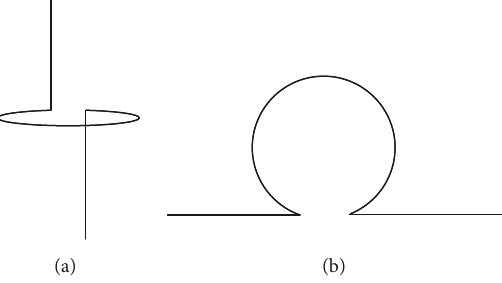
Figure 5: (a) Chiral particle; (b) omega particle [96].